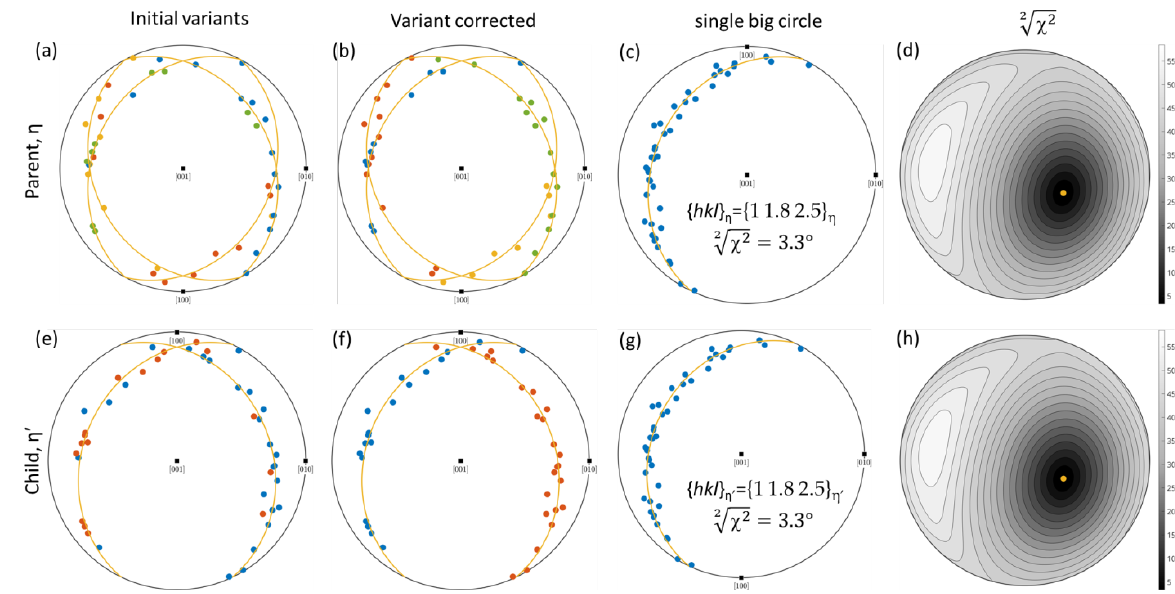
Figure 8. Stereographic projection of the measured traces (points) and habit planes (big circles) determined by the combined evaluation of misorientations and traces for the orthorhombic η phase ( a – c ) and the pseudo-orthorhombic η′ phase ( d – f ). The trace points are colored according to the parent and child variant ID v n and v ′ n due to the chosen parent and child symmetries 𝐒 P(𝑣 𝑛 ) and 𝐒 C(𝑣 𝑛′ ) derived from optimizing Equation (10). Diagrams ( a , d ) show the traces of η′ and η colored according to their parent and child variant ID v n and v ′ n . In ( b , f ), an additional correction for pseudosymmetry is applied. The variant-adjusted traces in ( c , g ) show a good fit to a single big circle. The ( hkl ) from 𝜒 2 minimization are given in ( c , g ). In ( d , h ), the direction-dependent value √𝜒 2 2 is illustrated after mapping all traces onto a single big circle. The orange points indicate the determined habit plane poles at the minimum.